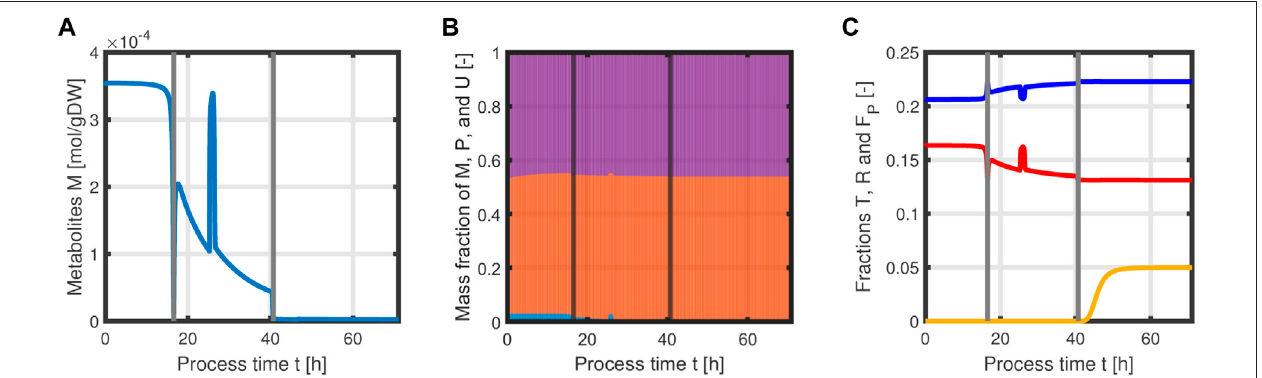
FIGURE8| TimecourseofintracellularconcentrationsoftheL-phenylalanineprocess:metabolites M (A) ,massfractionsofproteins P (violet),andresidualbiomass U (orange) and metabolites M (blue), where M becomes negligible in the last process phase (B) . Mass fractions of T (blue), R (red), and F (yellow) over the course of the process (C) .